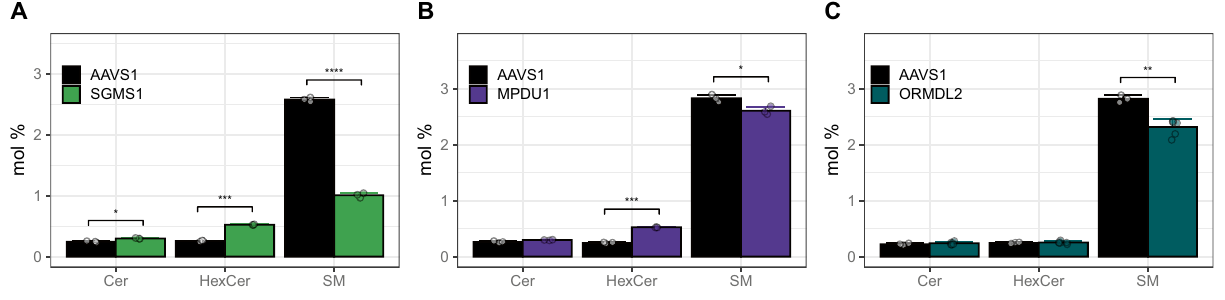
Figure 4. Sphingolipid Class effects: ( A – C ): Sphingolipid classes of the knockouts indicated compared to the AAVS1 control. ( A ) SGMS1 KO: See details in Suppl. Figure S06. ( B , C ) MPDU1 KO and ORMDL2 KO: See details in Suppl. Figure S07.